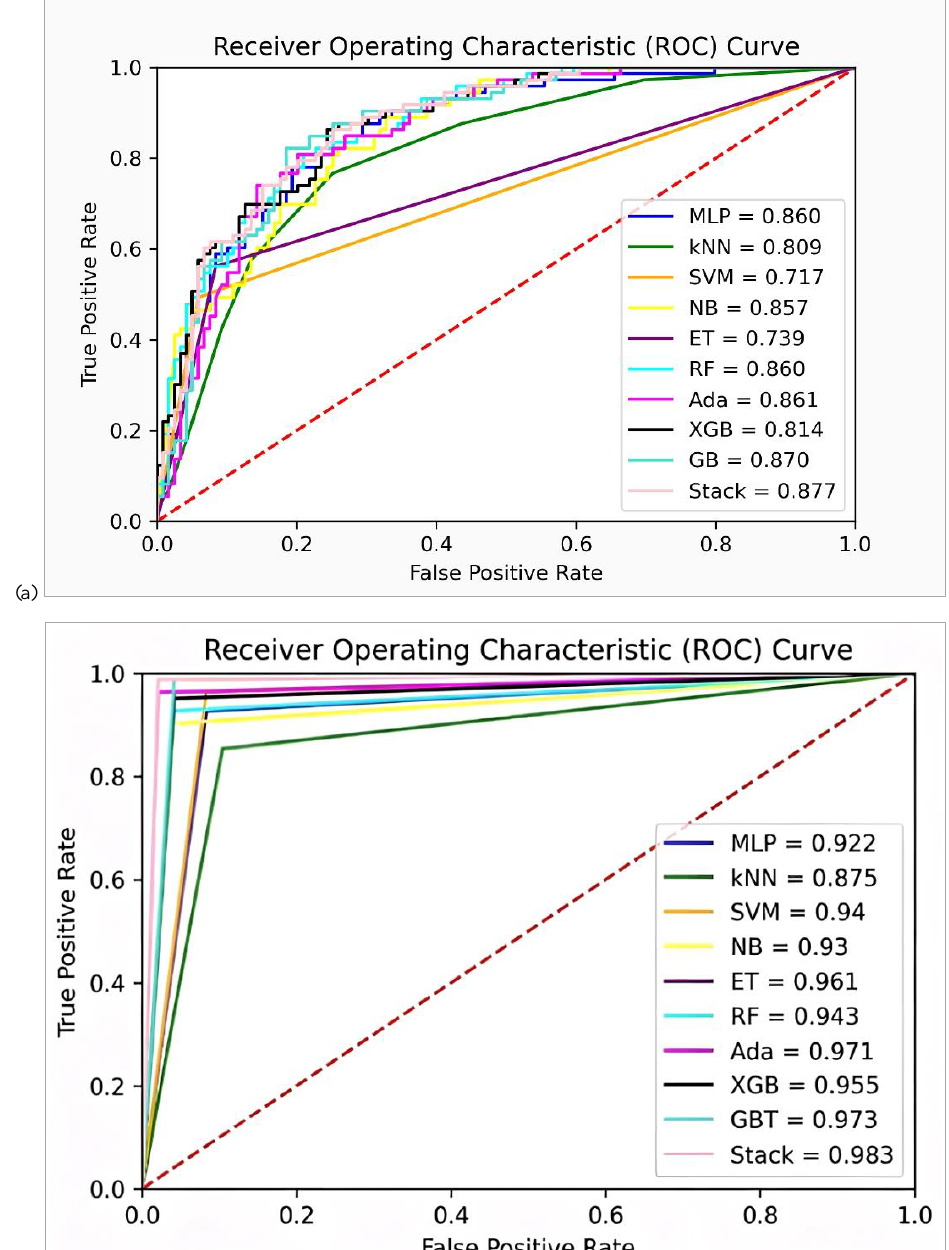
Figure 6. a) Comparison of ROC-AUC scores of Pima diabetes dataset, b) Comparison of ROC-AUC scores of Early-stage diabetes